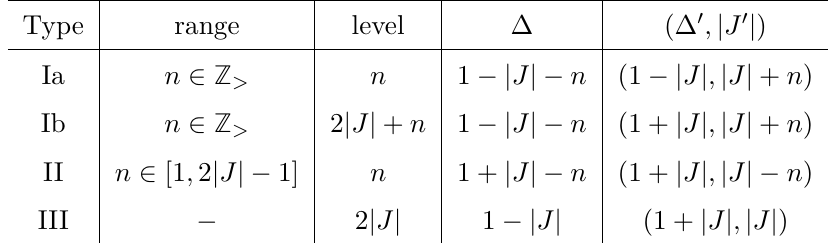
Figure 1. Diamond illustrating the nested submodule structure. The SL(2, C ) module of the primary | 1 − k , 1 − ¯ k i contains three submodules associated with primary descendant operators. 2 2